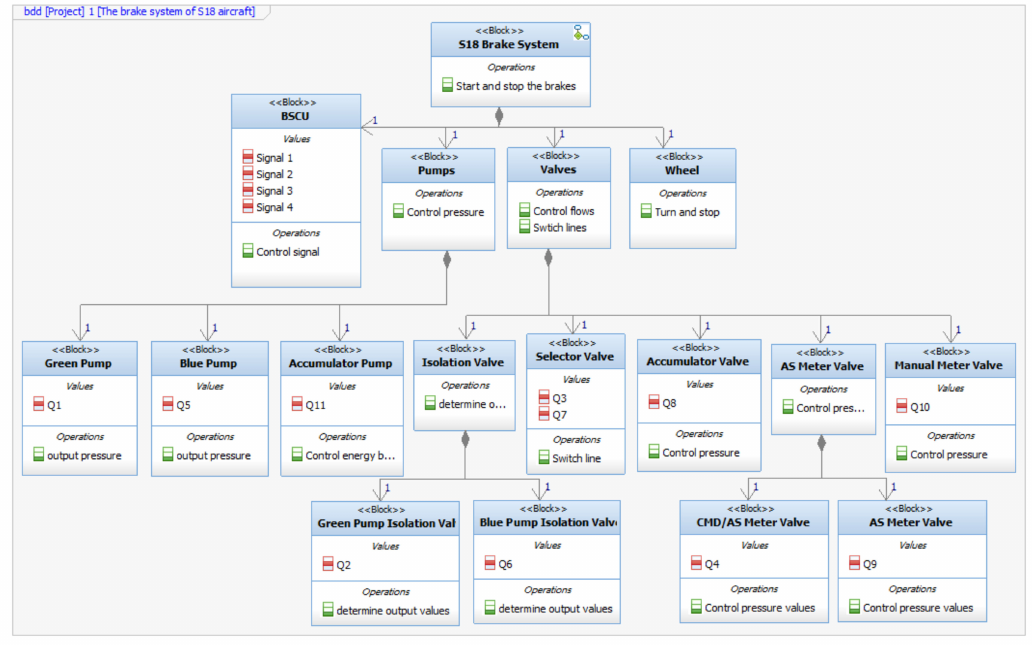
Figure 5. BDD of brake system.